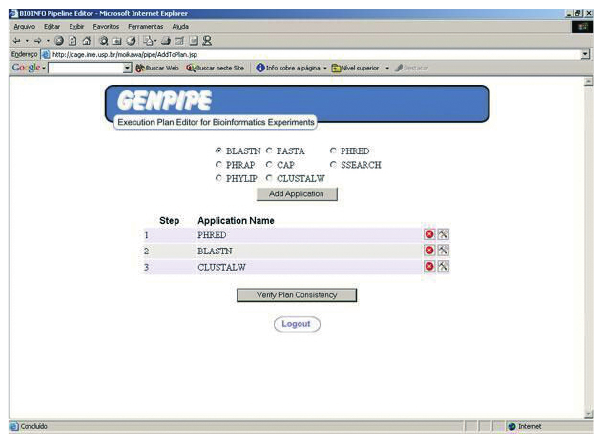
Figure 3 - Definition of the GenFlow: editing the task flow for an experi- ment.